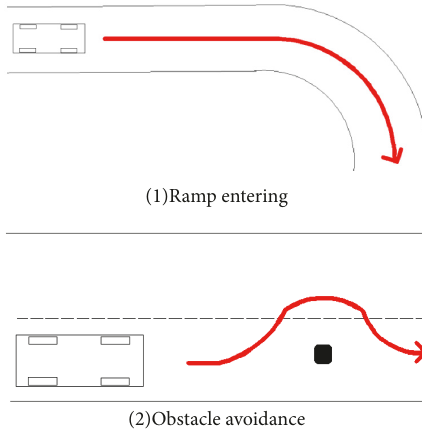
Figure 3: Bus rollover conditions.